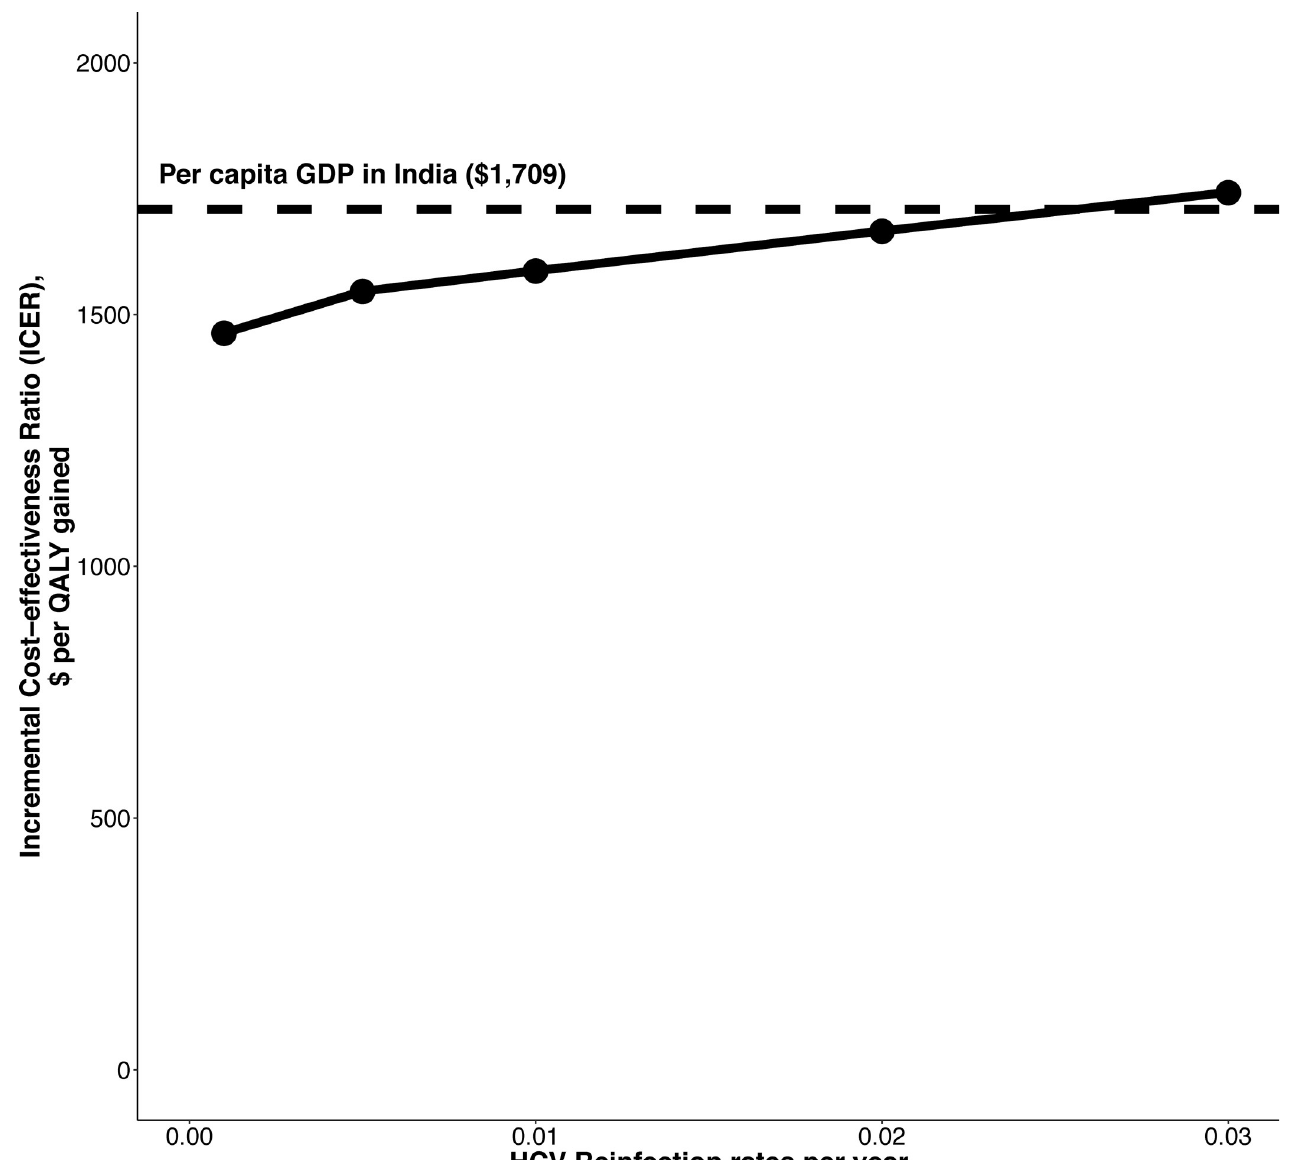
Fig 2. Incremental cost-effectiveness ratio of treating F0-F4 compared to F2-F4 in India for various reinfection rates from 0.5–3% per year. Dashed line shows the ‘highly cost-effective’ 1xGDP threshold for India ($1,709). ICER: Incremental cost-effectiveness ratio.